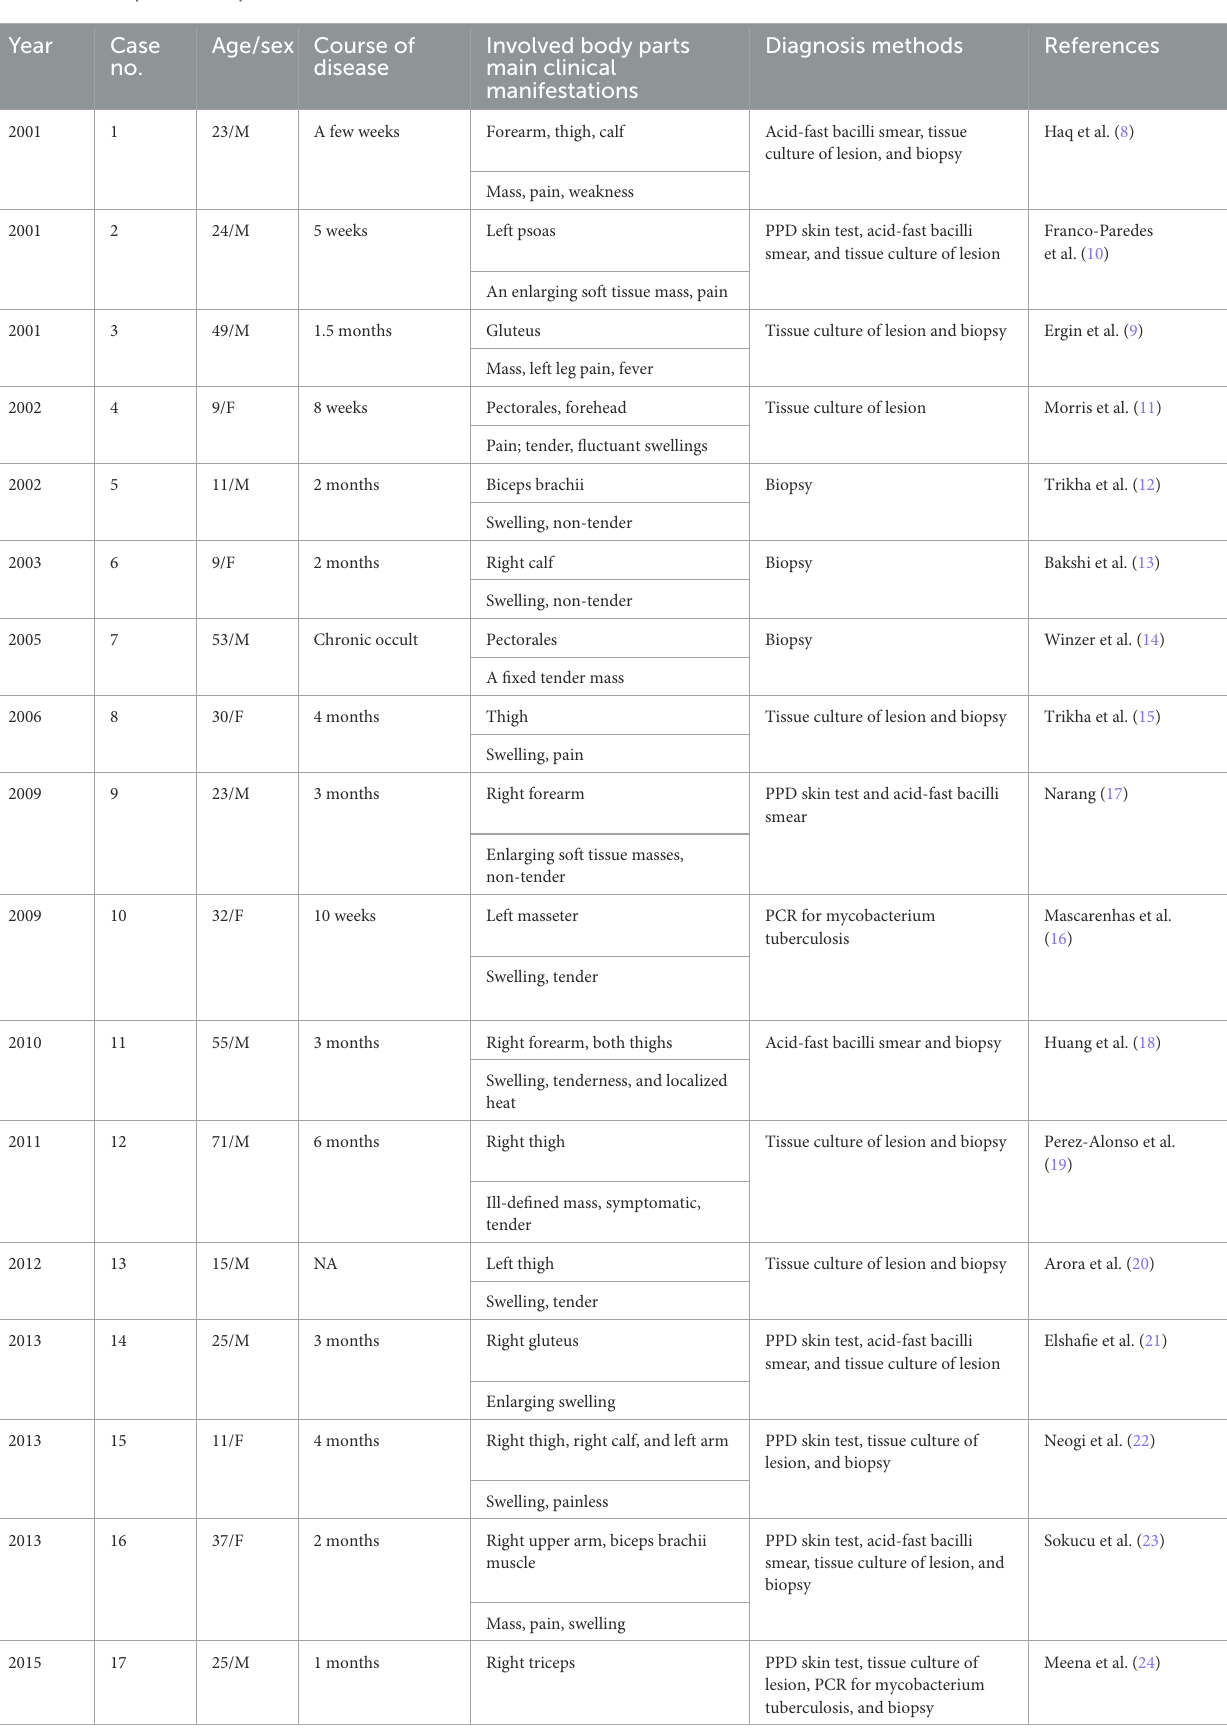
TABLE 1 Clinical profiles of reported cases of